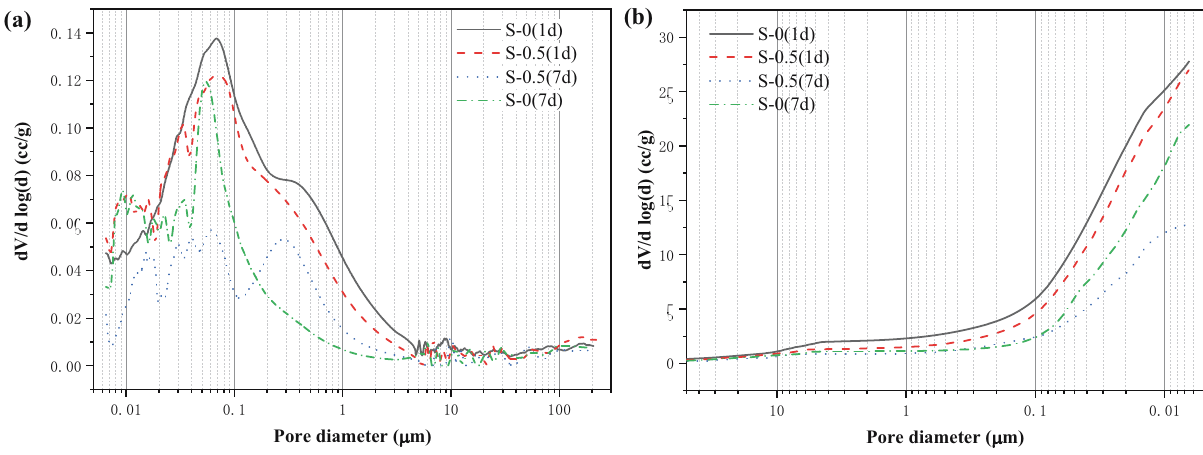
Figure 6: Pore size distribution curves of di ff erent cement pastes: ( a ) di ff erential distribution curves and ( b ) cumulative distribution curves.